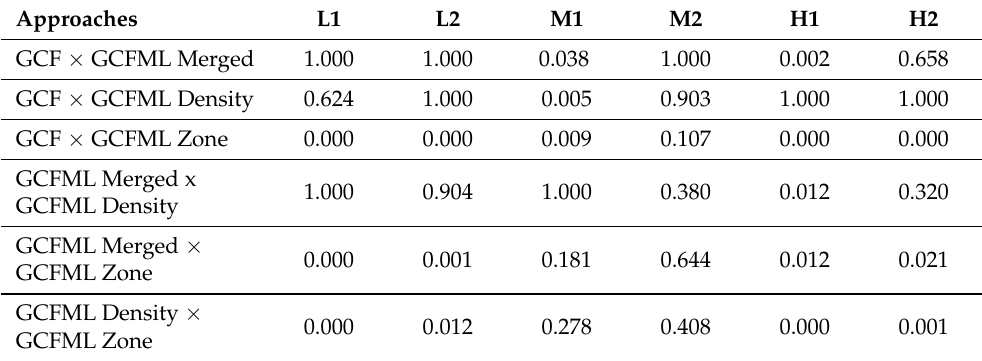
Table 7. Statistical Tests of the Average Offloading Time in the